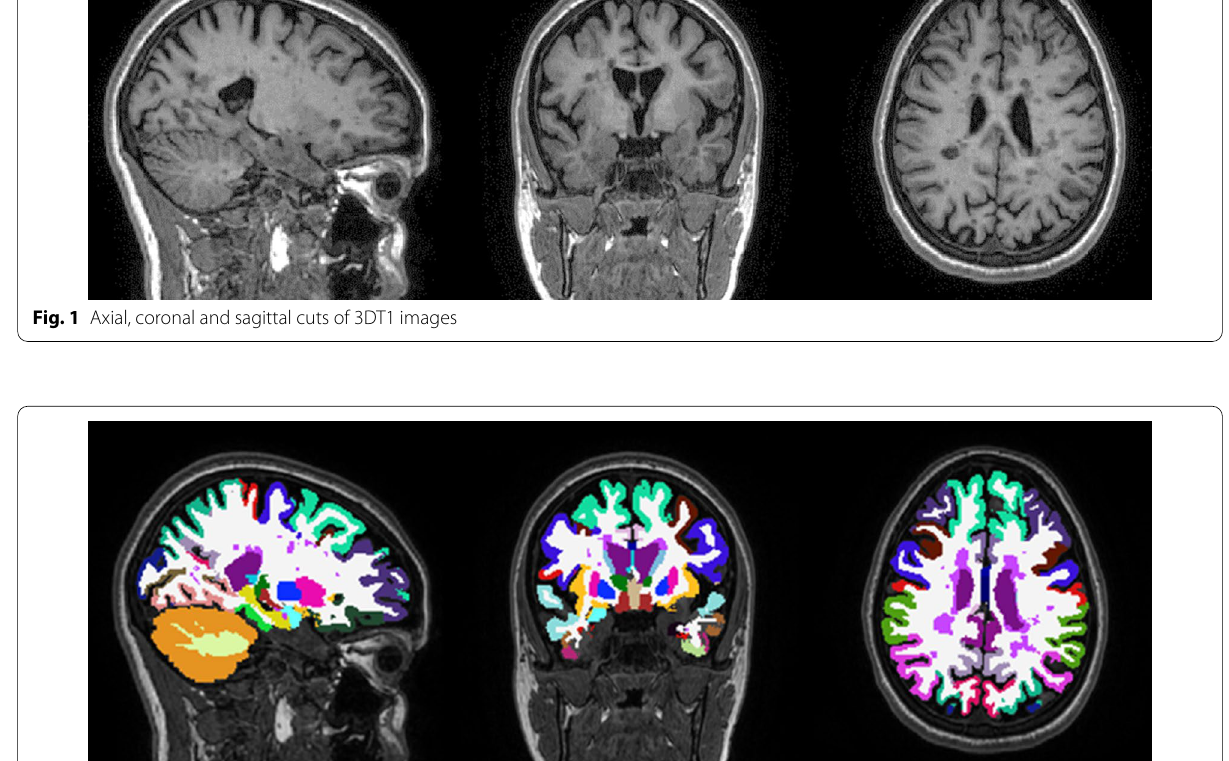
Fig. 2 Cortical and deep gray matter segmentation using free surfer